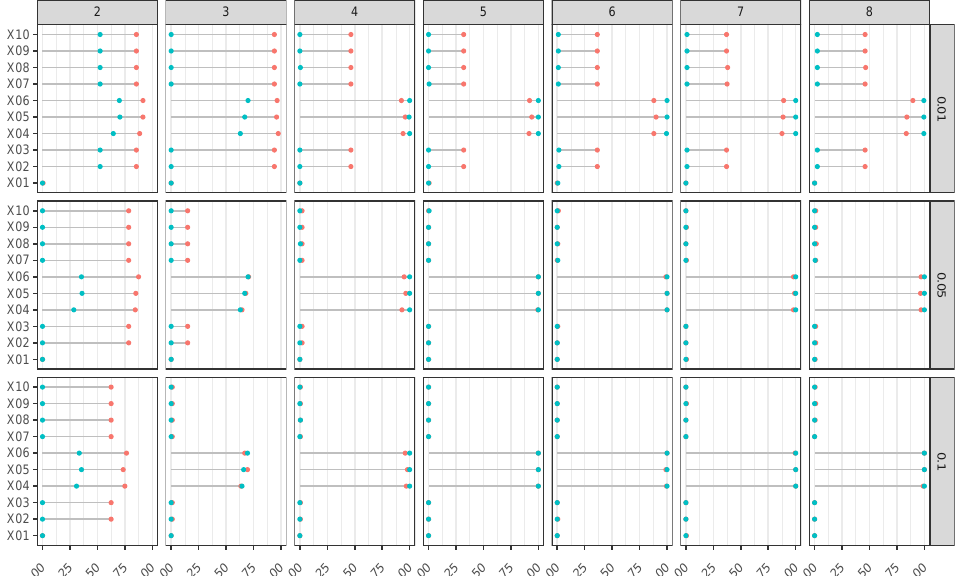
Figure 8. Model M2 (DeVleaux). Proportion of rejections of null hypothesis based on k -FWE test with k = 1 for 10 input variables, different combinations of hidden layer sizes ( m ∈ { 2,3, . . . ,8 } ), and of weight-decay values ( λ ∈ { 0.01,0.05,0.1 } ). Nominal FWE was fixed at α = 0.10, 500 Monte Carlo runs, B = 999 bootstrap replicates, and n = 300 (in red) and n = 1000 (in